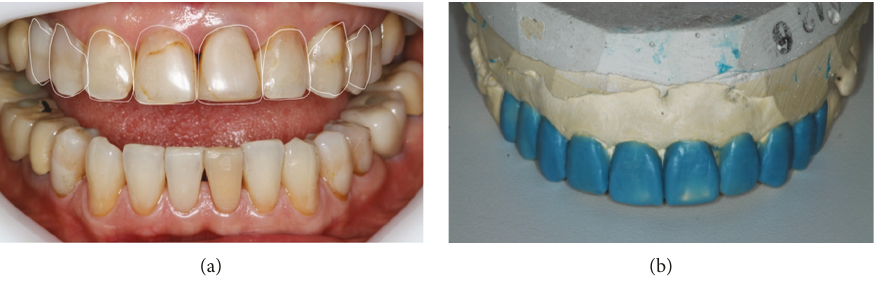
Figure 3: (a) Digital smile design. (b) Wax-up upper arch.